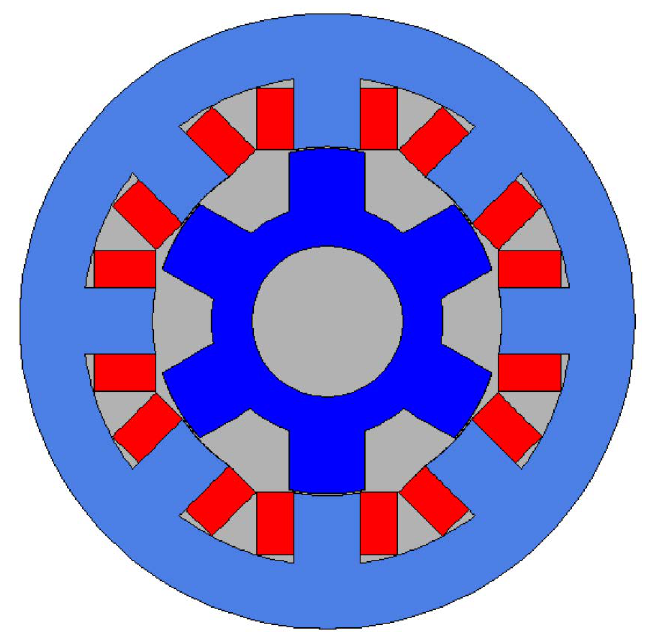
Figure 16. A 2D Model of an 8/6 motor.